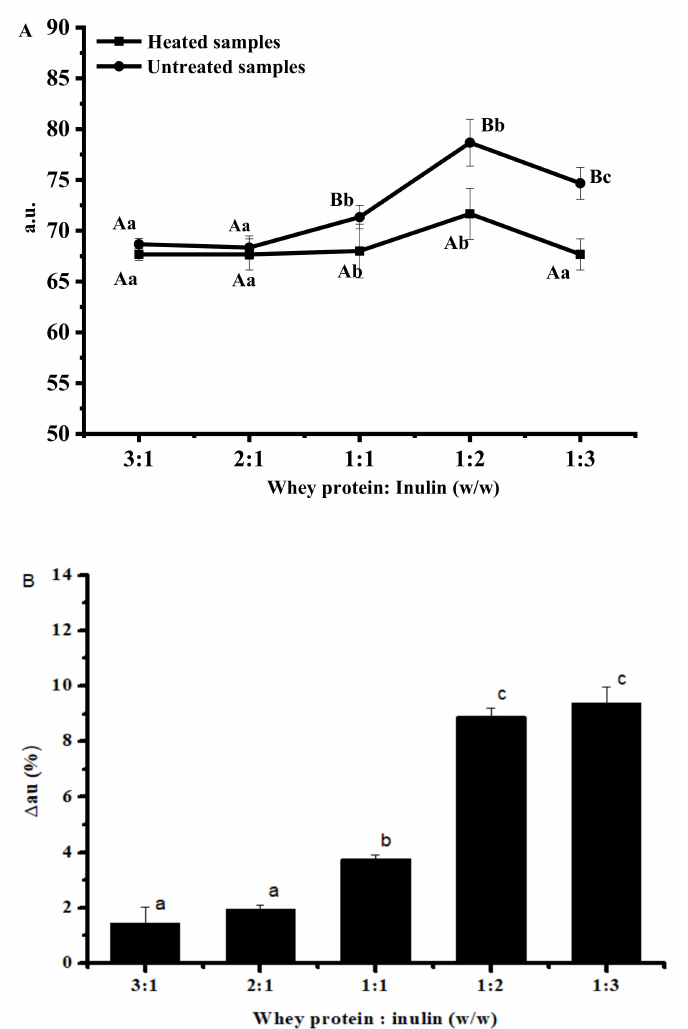
Figure 2. Free amino acid content (expressed by fluorescence intensity) of heated and untreated whey protein and inulin mixtures ( A ) and changes in fluorescence intensity of whey protein and inulin mixture after heating ( B ). Di ff erent lowercase letters denote significant di ff erence between samples at di ff erent ratios; Di ff erent uppercase letters denote significant di ff erence between untreated and dry-heated samples at same whey protein and inulin ratio. Error bars are ± SD of the